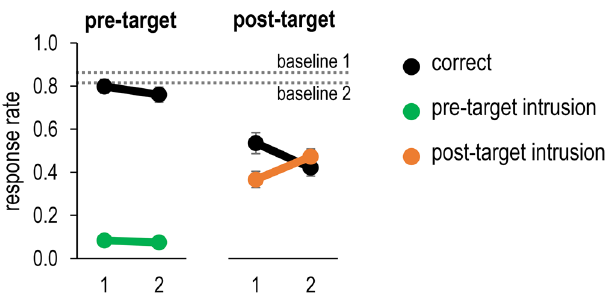
Figure 4. Frequency of correct responses (black lines), pre-target intrusions (green lines) and post-target intrusions (orange lines) in Experiment 1, as a function of the distractor condition (pre-target digit vs. post- target digit) and the number of streams (1 vs. 2). Error bars denote one standard error. The dotted lines represent baseline accuracy (i.e., no pre/post-target digit distractors) based on the number of